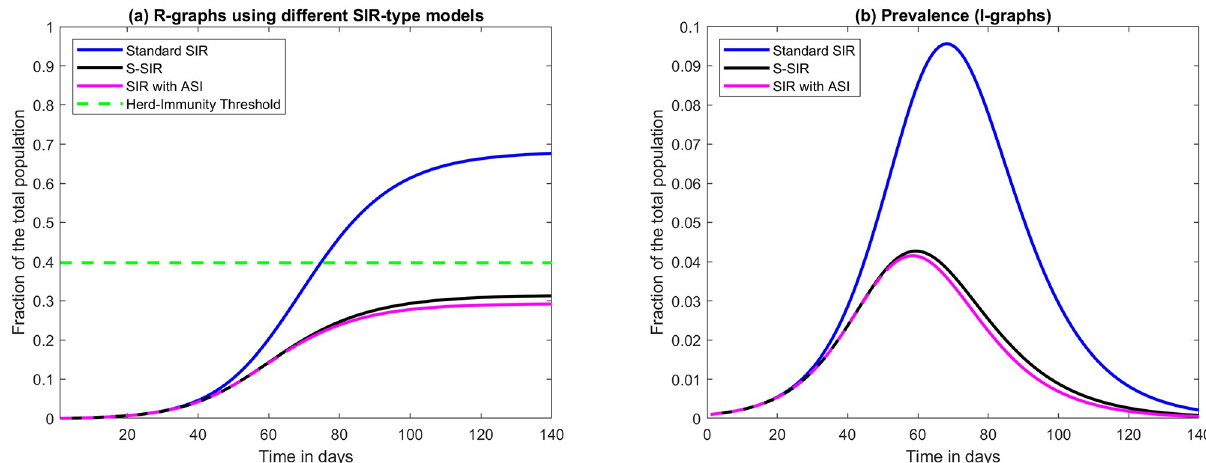
Fig 1. Graphs of recovered R and prevalence I . (a) Graphs of recovered (as a fraction of the total population) for various SIR-models and a fixed value of R 0 = 1.66. First we display standard SIR, then S-SIR and finally SIR with Artificial Sterilizing Immunity (ASI) with parameters from (8). Note that they start out almost identically but that the latter two bend downwards much earlier than the first, which over-shoots the classical Herd-Immunity Threshold (HIT), whereas the second two stay closely together and level out below the classical HIT. (b) Corresponding curves for prevalence I (the S - graphs are shown independently in Fig